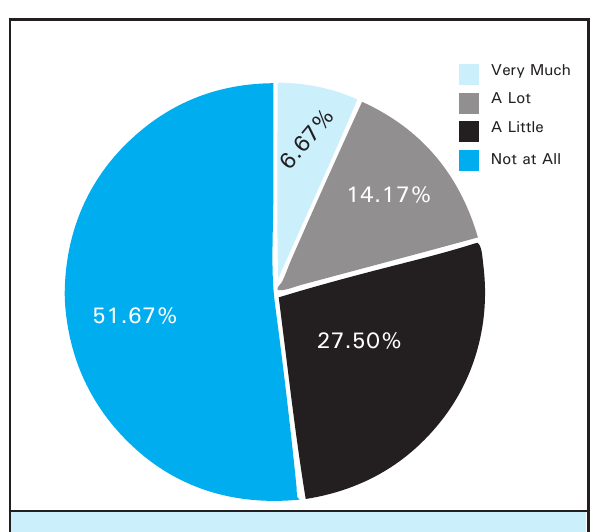
Figure 2. Impact on self-consciousness.